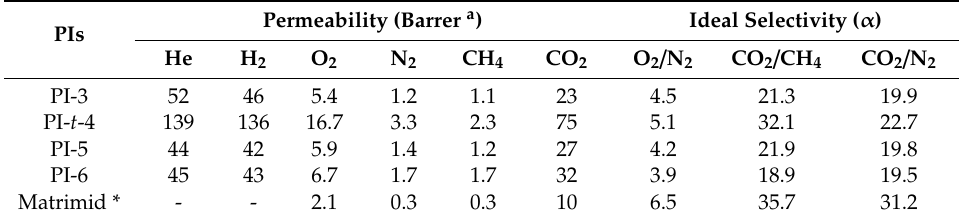
Table 5. Pure gas permeabilities and ideal selectivity for